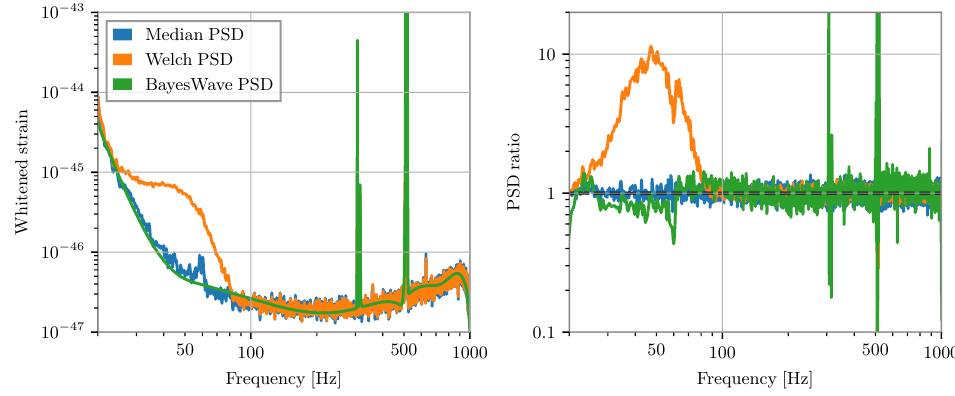
Figure 12. A comparison of different methods to estimate the power spectral density of time domain data that contains a non-Gaussian artifact. Left: The calculated PSD for simulated data using the Median method [159], Welch’s method [158], and BayesWave [138,140]. Right: The ratio of the calculated PSD to the known PSD using each method. The PSD calculated with Welch’s method is severely biased due to the non-Gaussian artifact in the data. The BayesWave PSD does not capture all of the features in the known PSD due to fitting the PSD with a spline, but has the benefit of using significantly less data than the Median method and hence is less impacted by non-stationary noise. Plotted data are simulated using GWpy [163] and Bilby